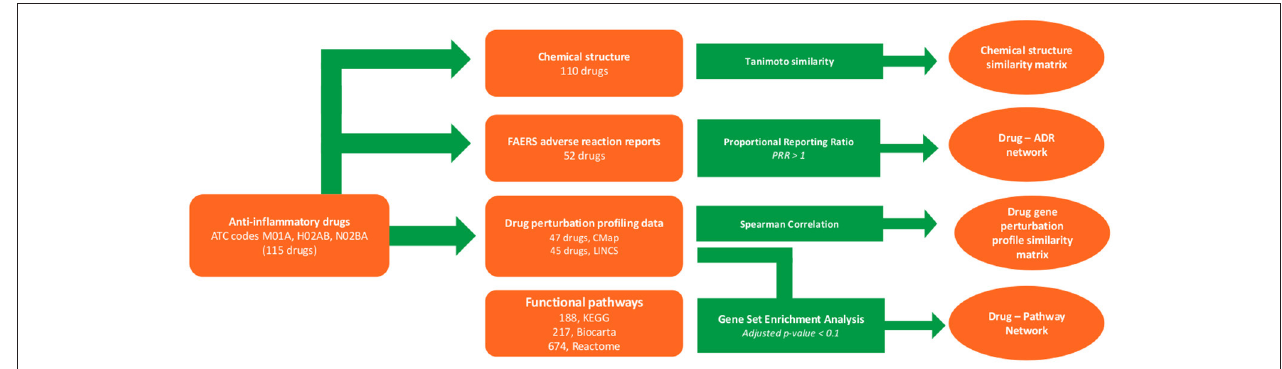
FIGURE 1 | Methodological pipeline. The workflow used here consists of the following steps. First, drugs with anti-inflammatory therapeutic indications were identified. Their chemical structures, drug perturbation profiles, and adverse drug reactions (ADRs) were then collected from databases, along with functional pathway information. These collected data were used to construct similarity matrices (based on chemical or gene perturbation), drug-pathway perturbation networks, and drug-ADR networks.